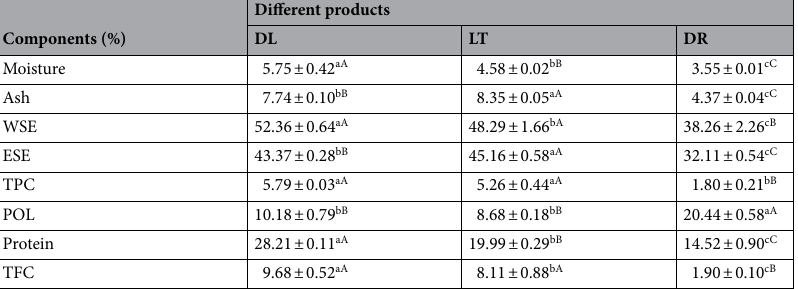
Table 1. Bioactive components in three products from Astragalus membranaceus (Fisch.) Bge. The data are presented as the means ± SDs. DL, dry leaves; LT, leaf tea; DR, dry roots; WSE, water-soluble extract; ESE, ethanol-soluble extract; TPC, total polyphenolic content; POL, Polysaccharides; TFC, total flavonoid content. In each column, the different lowercases and uppercases mean significant difference at P < 0.05 and great significant difference at P < 0.01, respectively, based on results of ANOVA-Duncan multiple comparisons by SPSS 20.0. All the abbreviation is the same as following